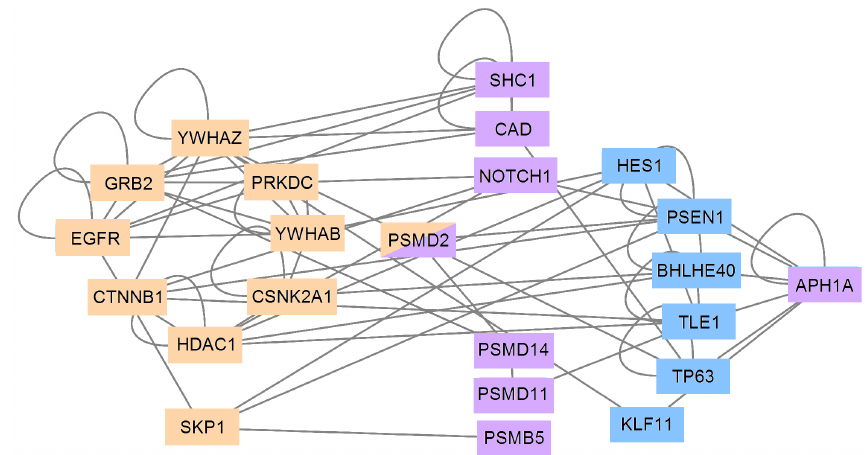
Figure 6. Interaction network of proteins from genes of Tables 3 and 4. Table 3 (PCA) genes are represented on beige blocks and form a major component. Most genes of Table 4 (RFC) are represented on purple blocks and are from Table 3, except APH1A , H2AFZ , and TMEFF2 . H2AFZ and TMEFF2 were disconsidered here because they have low connectivity rates. APH1A is connected to the major network component through six intermediary proteins (blue) as appeared according to the IntAct